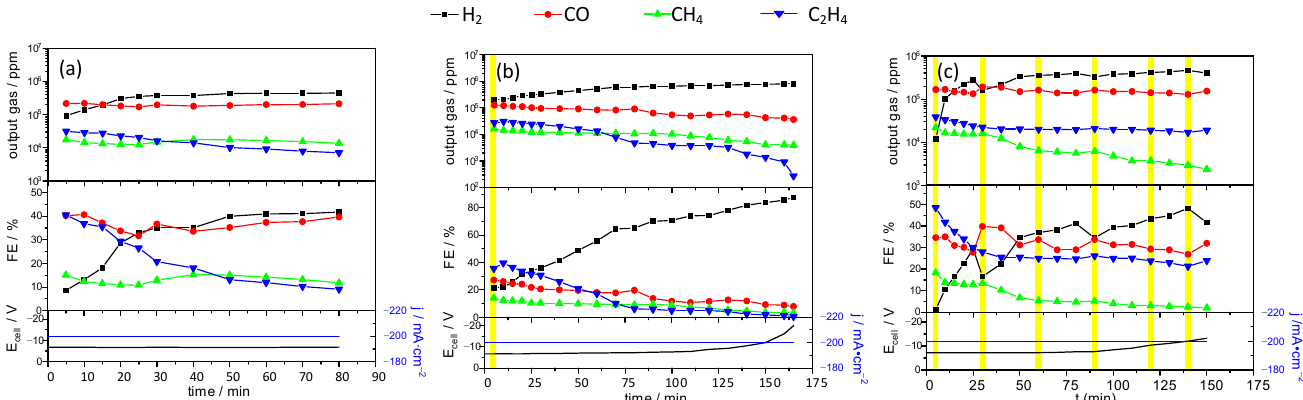
Figure 7. Output gas composition and Faradaic efficiency of CO 2 conversion for: ( a ) without C 6 H 10 CuO 6 addition; ( b ) single C 6 H 10 CuO 6 addition at the beginning of the experiment, and ( c ) the effect of the multiple C 6 H 10 CuO 6 additions with ca. 30 min time intervals (200 mA·cm − 2 , 1 M KHCO 3 ). Each copper lactate injection is marked as a yellow bar.